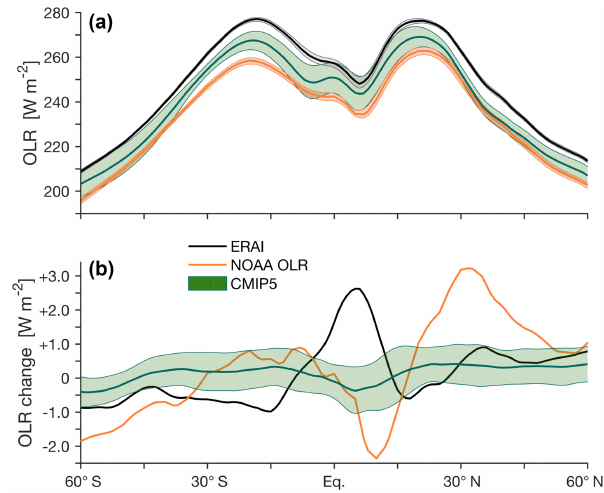
Figure 5. Outgoing longwave radiation (OLR) at the top of the atmosphere in CMIP5 models (green), ERAI (black), and the Na- tional Oceanic and Atmospheric Administration (NOAA) interpo- lated OLR dataset (orange; Liebmann and Smith, 1996). (a) The mean OLR during 1979–2004. (b) The difference in OLR between the decades beginning in 1995 and 1979. The shading indicates ± 1 standard deviation of inter-model spread for CMIP5 models and of interannual variations for ERAI and the NOAA interpolated